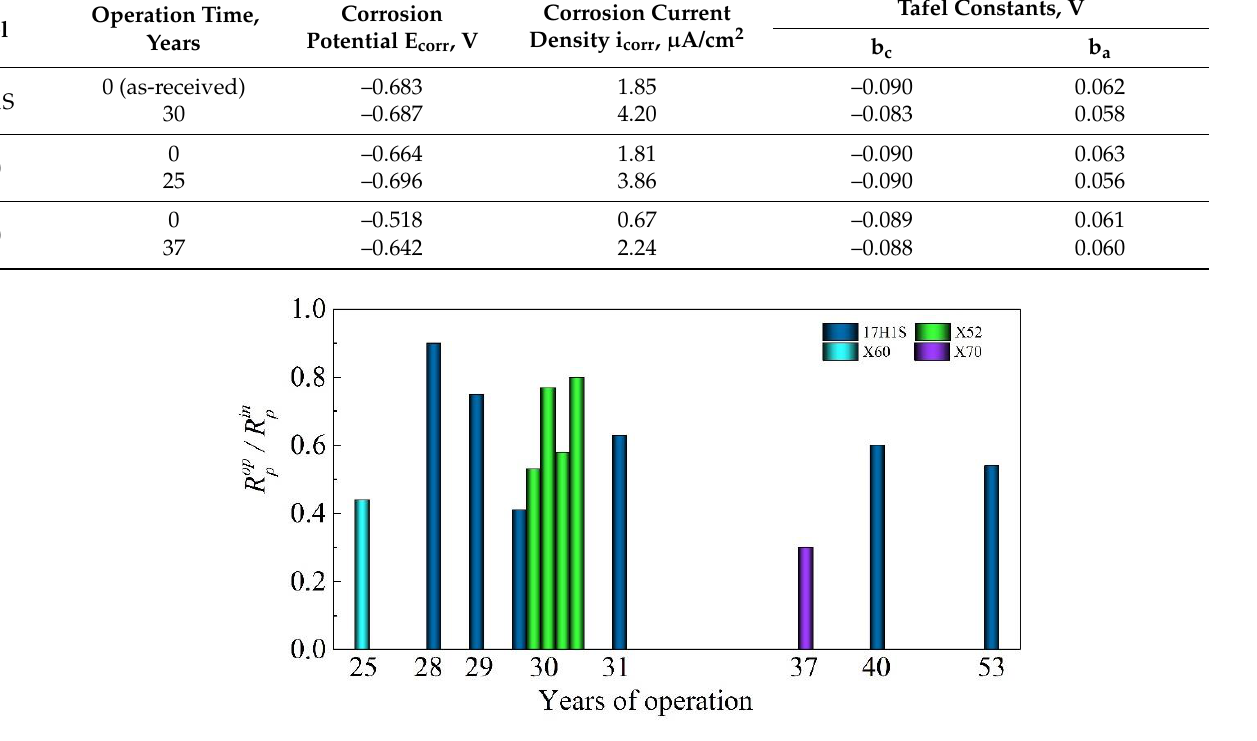
Figure 2. The changes in polarization resistance for 17H1S, X52, X60, and X70 pipe steels as a result of long-term operation R opp relative to the corresponding values in the as-received state R inp .